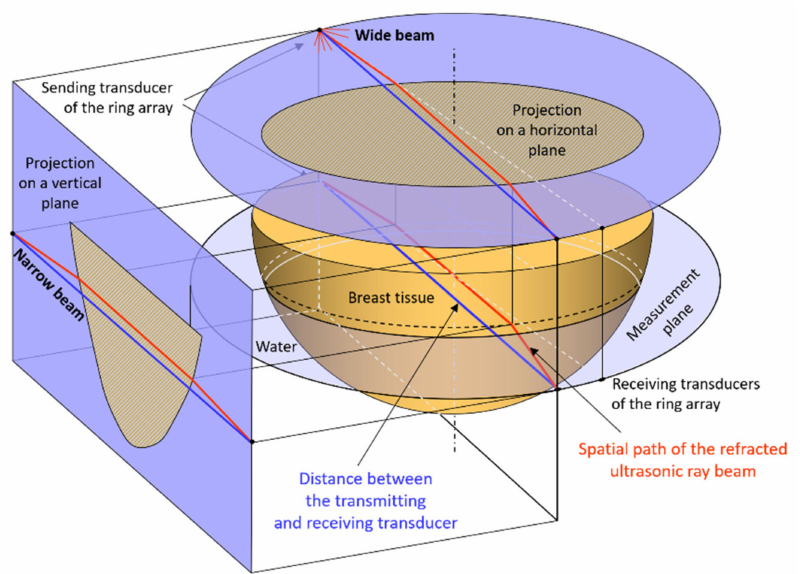
Figure 18. Illustrative representation of the spatial path of the refracted ultrasound wave ray through water and breast tissue from the selected sending transducer to the receiving transducer of the ring array and the selected horizontal measurement plane, and orthogonal projections of this path in the horizontal and vertical